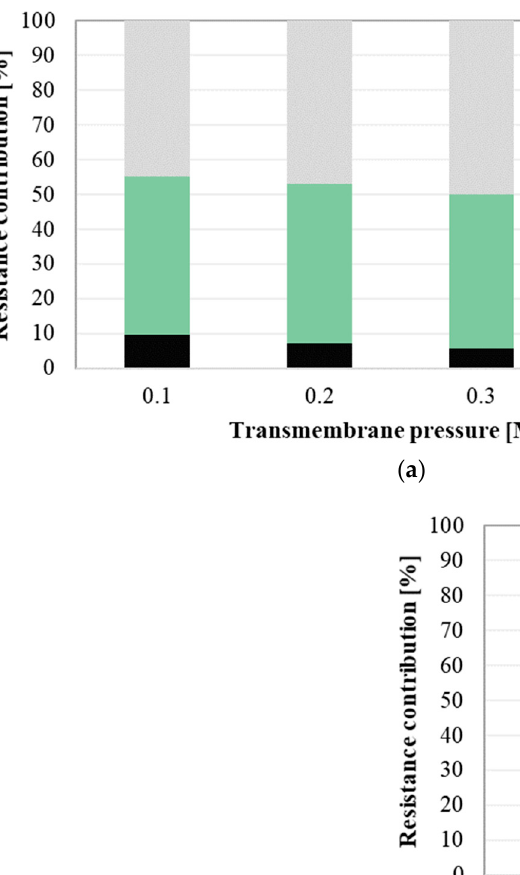
Figure 8. Resistances contribution as a function of transmembrane pressure. Q (dm 3 /h): ( a ) 200, ( b ) 300, ( c ) Q = 400 irreversible fouling, reversible fouling, membrane.